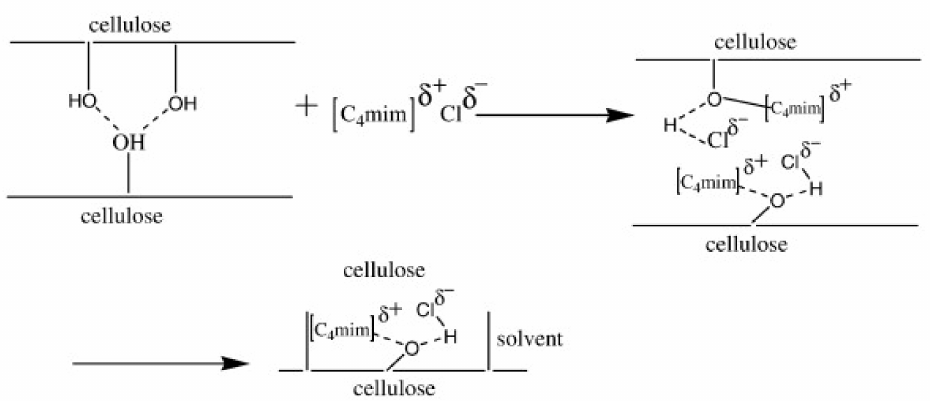
Figure 6. Typical mechanism of cellulose dissolution in IL. Reprinted from [180] with permission from Elsevier ©